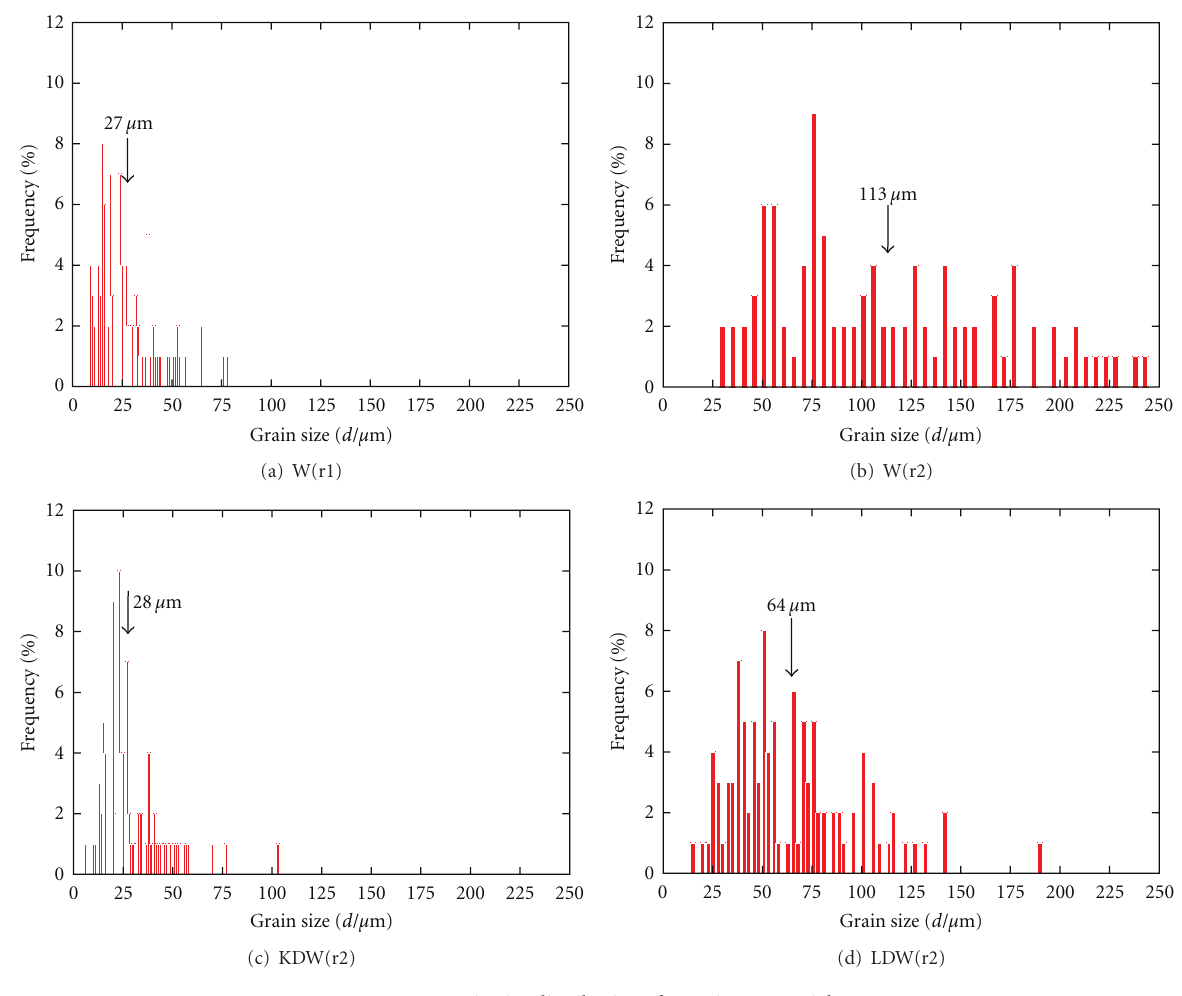
Figure 2: Grain size distributions for various materials.